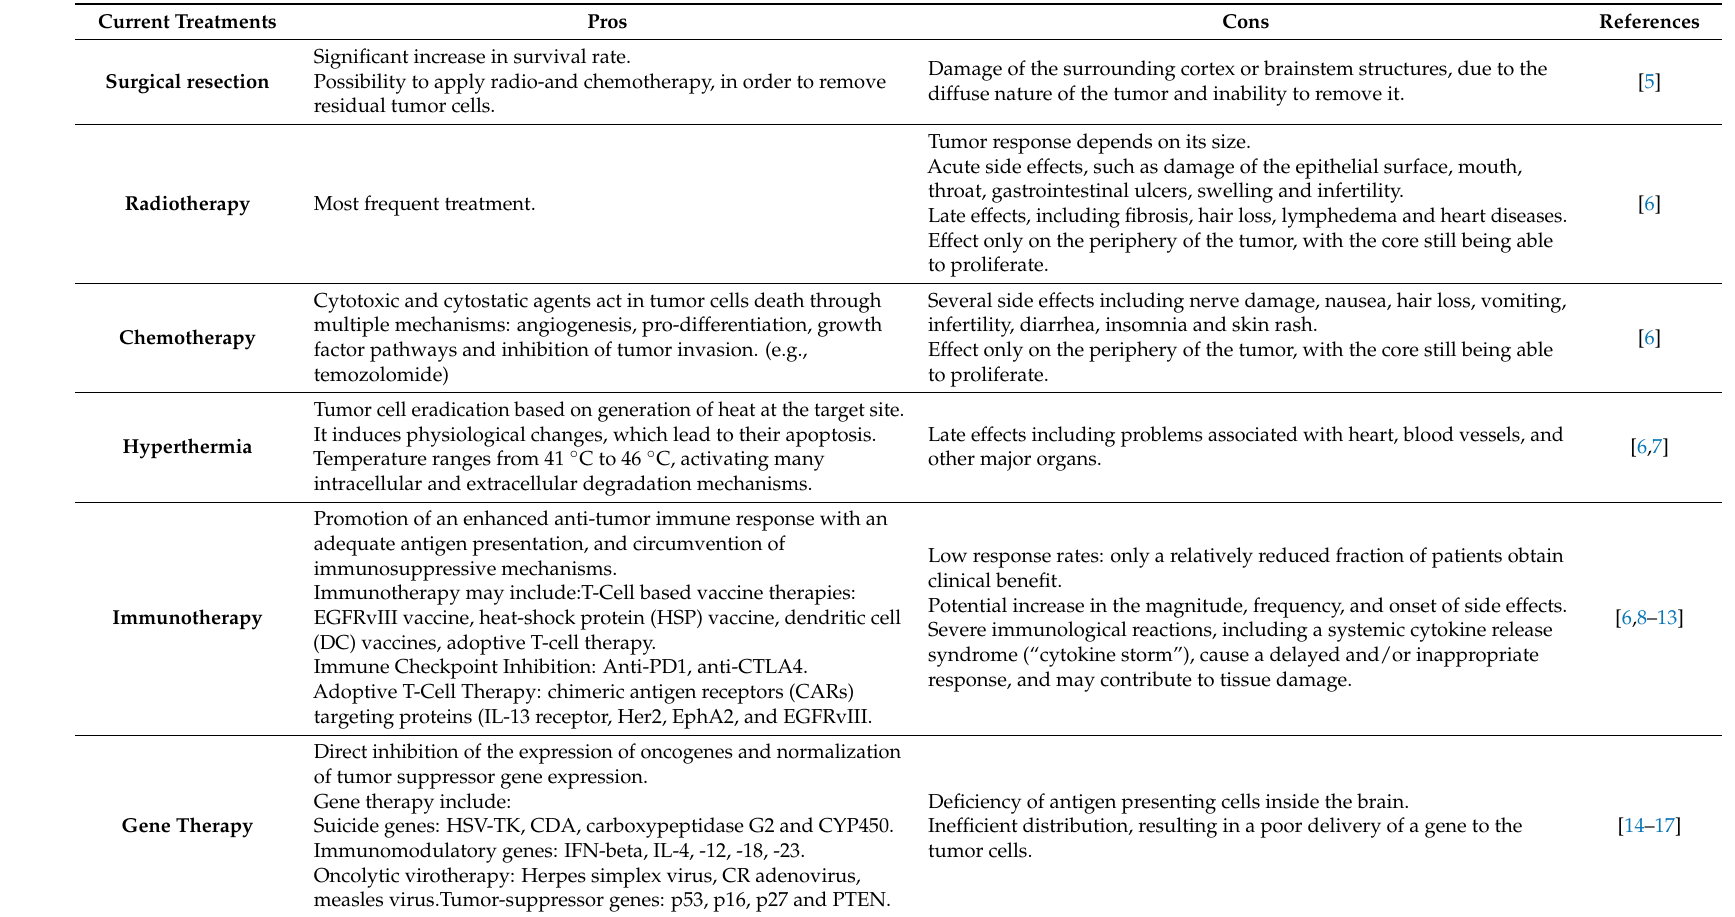
Table 1. Current glioblastoma (GB) treatments: limitations and